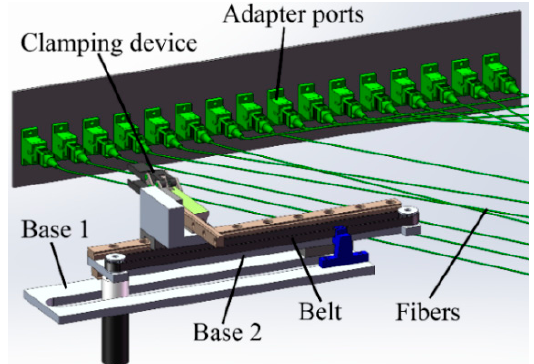
Figure 11. Three-dimensional model of the rapier robot.